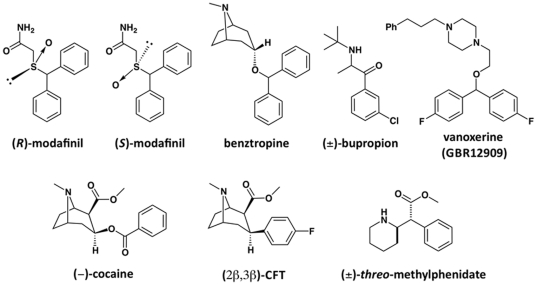
Chemical structures of modafinil and other tested DAT inhibitor ligands.Atypical inhibitors (top row) exhibited preferential interaction with a more inward-facing transporter conformation, whereas cocaine-like inhibitors (bottom row) preferentially bound to the outward-facing DAT conformation. While modafinil has a chiral sulfoxide moiety, the enantiomers possess little difference in pharmacodynamic activity (hence, only the racemate was tested).